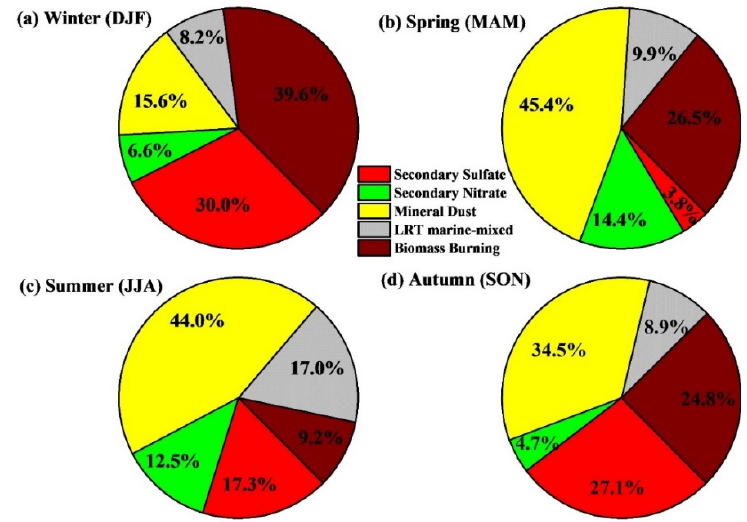
Figure 7. Percentage (%) contribution of PMF-identified factors to the modeled TSP mass on a sea- sonal basis ( a ) winter, ( b ) spring, ( c ) summer, ( d ) autumn. seasonal basis ( a ) winter, ( b ) spring, ( c ) summer, ( d ) autumn.